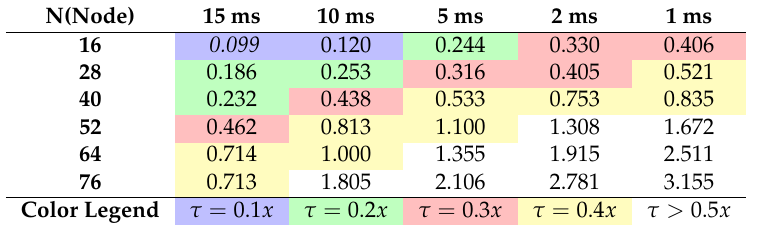
Table 1. The average elapsed time per transaction and the proportion of trouble transactions ( τ